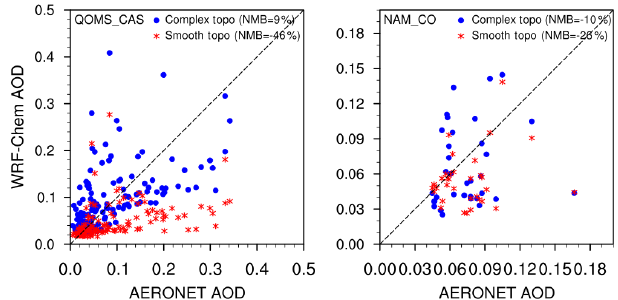
Figure 7. Hourly AOD from the measurements of AERONET and simulations by WRF-Chem at the two sites over the TP (QOMS_CAS at 86.95 ◦ E, 28.36 ◦ N; NAM_CO at 90.96 ◦ E, 30.77 ◦ N) for 1–20 April